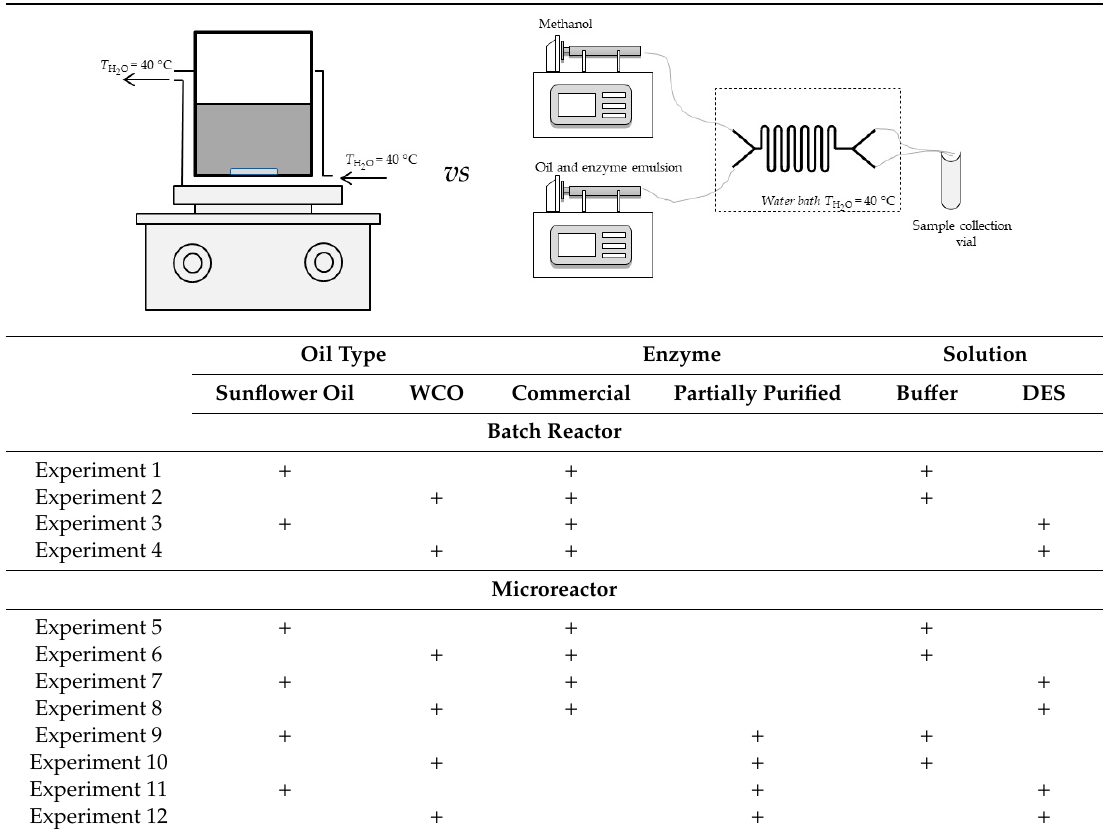
Table 1. Experimental setup and different reaction conditions during oil transesterification catalyzed by lipase performed in a batch reactor and in a microreactor system.